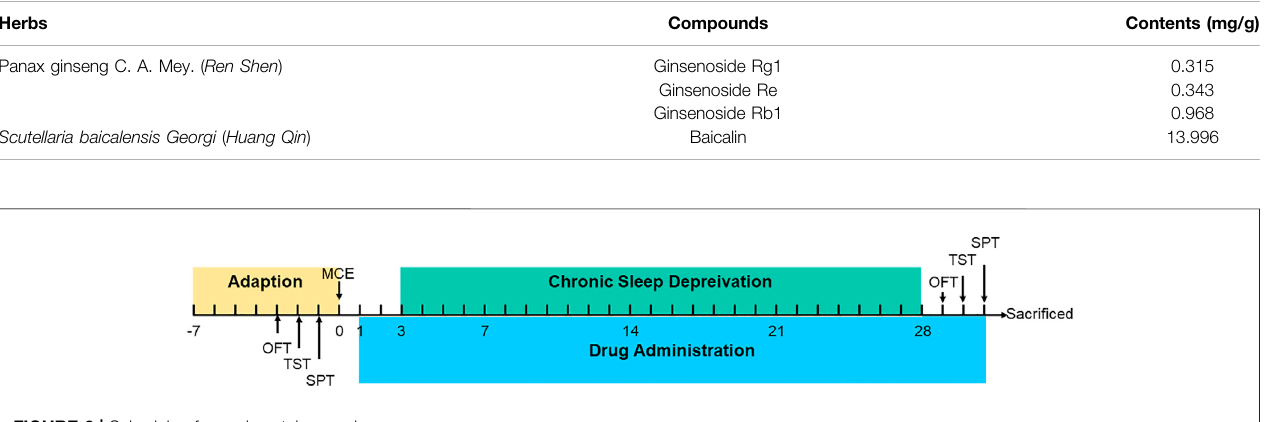
TABLE 2 | Contents of the main identi fi ed compounds in JDTL